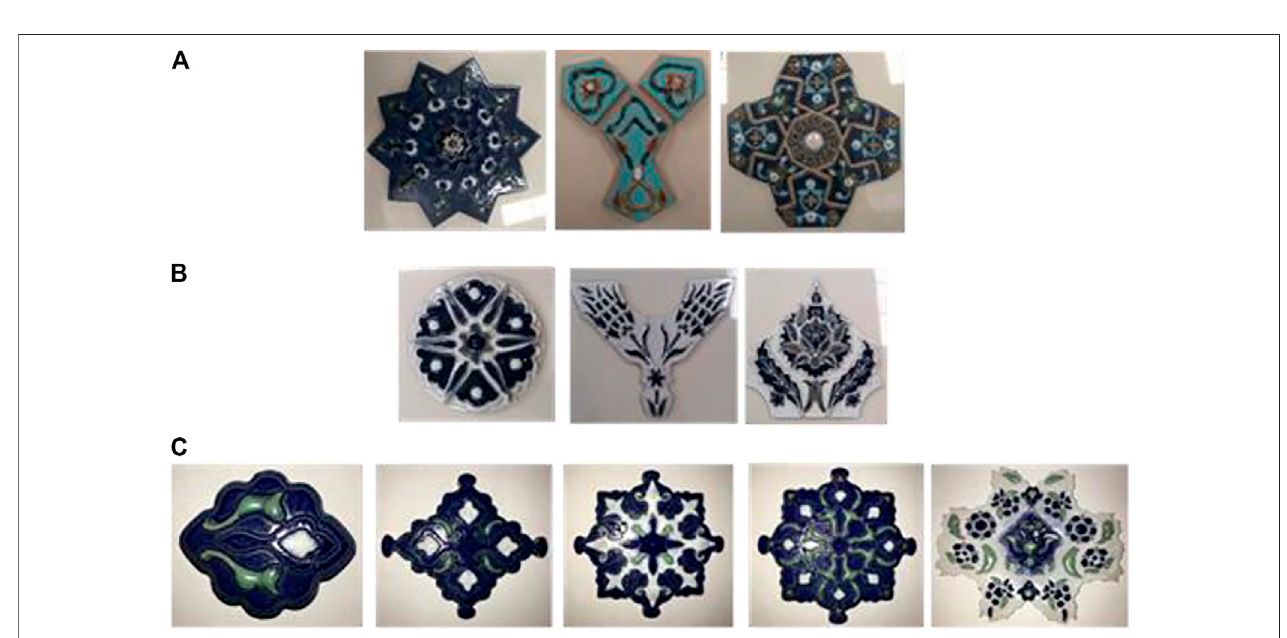
FIGURE 5 | Produced tile elements for (A) IGP/IBM tiles (pattern 005); (B) Iznik tiles (pattern 007); (C) Safavid tiles (pattern 008).